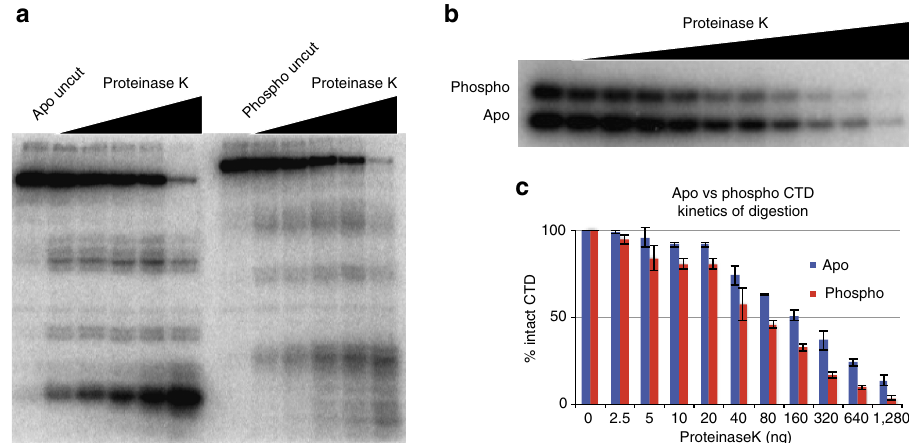
Figure 5 | Local structural heterogeneity is maintained in the phospho CTD but the phospho CTD is more accessible to protein interaction. ( a ) Limited proteolysis of the phospho CTD shows an altered pattern of proteolysis. The hypersensitivity of the distal site is reduced, and the pattern of proteolysis is more evenly distributed among the sensitive sites. The proximal sensitive region, and central protected region are preserved after phosphorylation, with proteolytic fragments shifted relative to the apo fragments due to phosphorylation across the CTD. ( b ) Representative limited proteolysis of a mixture of apo and phospho CTD to compare protease accessibility. ( c ) Average of three replicates of the apo (blue bars) and phospho (red bars) mixing experiments quantified as the percentage of intact CTD remaining at each protease concentration. 100–50% intact CTD is the single hit kinetics range of the experiment 42 . Error bars depict